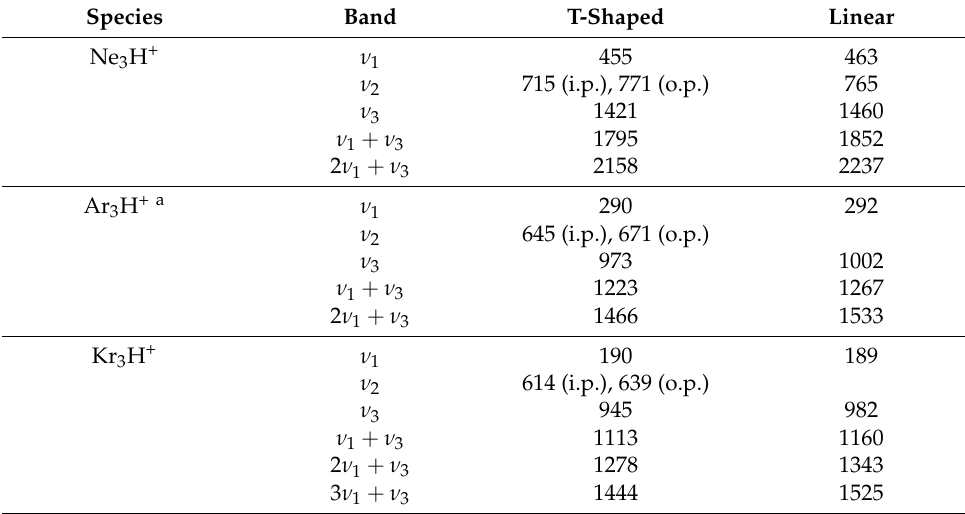
Table 7. Anharmonic frequencies for the T-shaped and linear isomers of Ng 3 H +